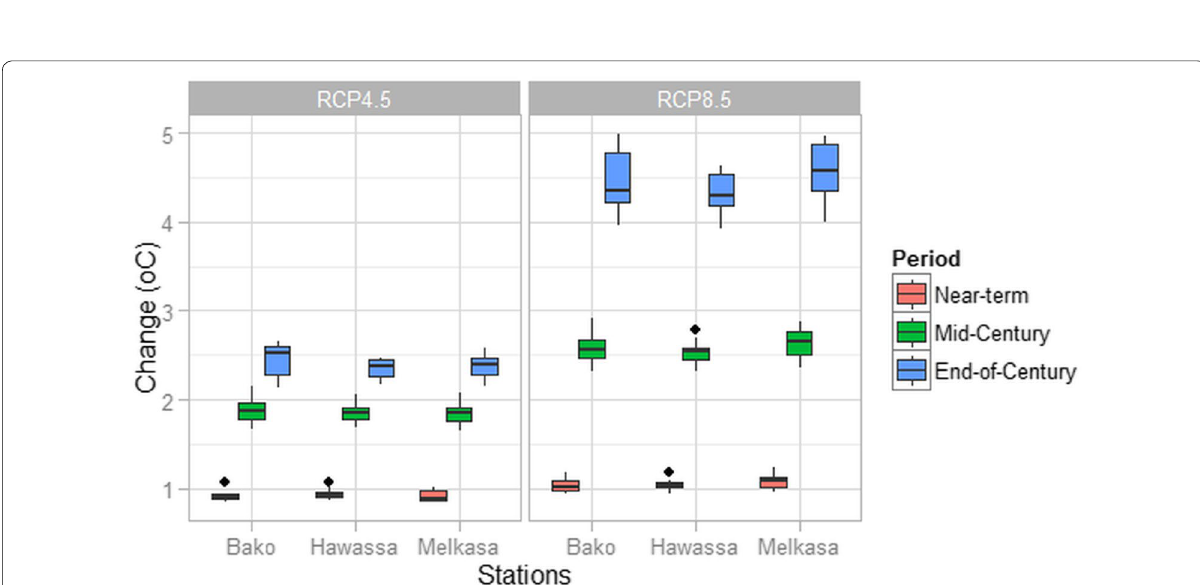
Fig. 3 Projected changes in monthly minimum temperatures for RCP4.5 (left) and RCP8.5 (right) for near term, mid-century and end of century future